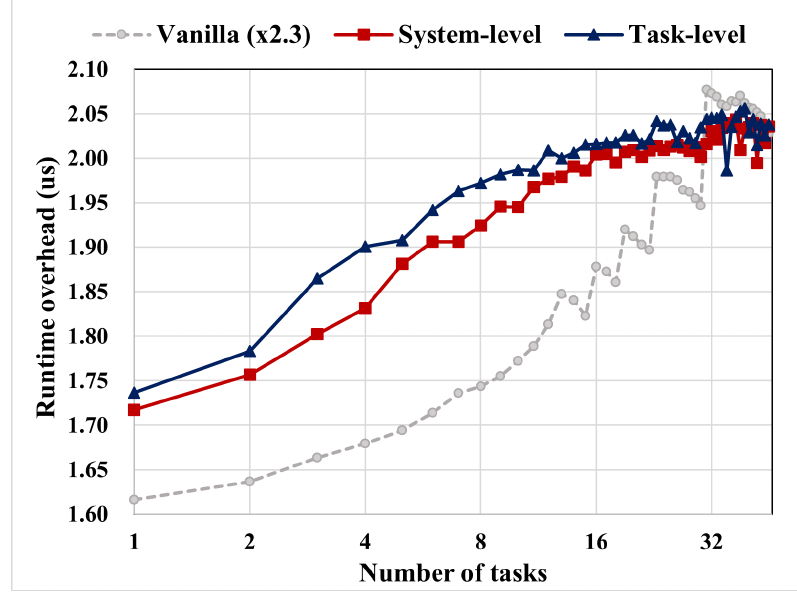
Figure 11. Runtime scheduling overhead by number of